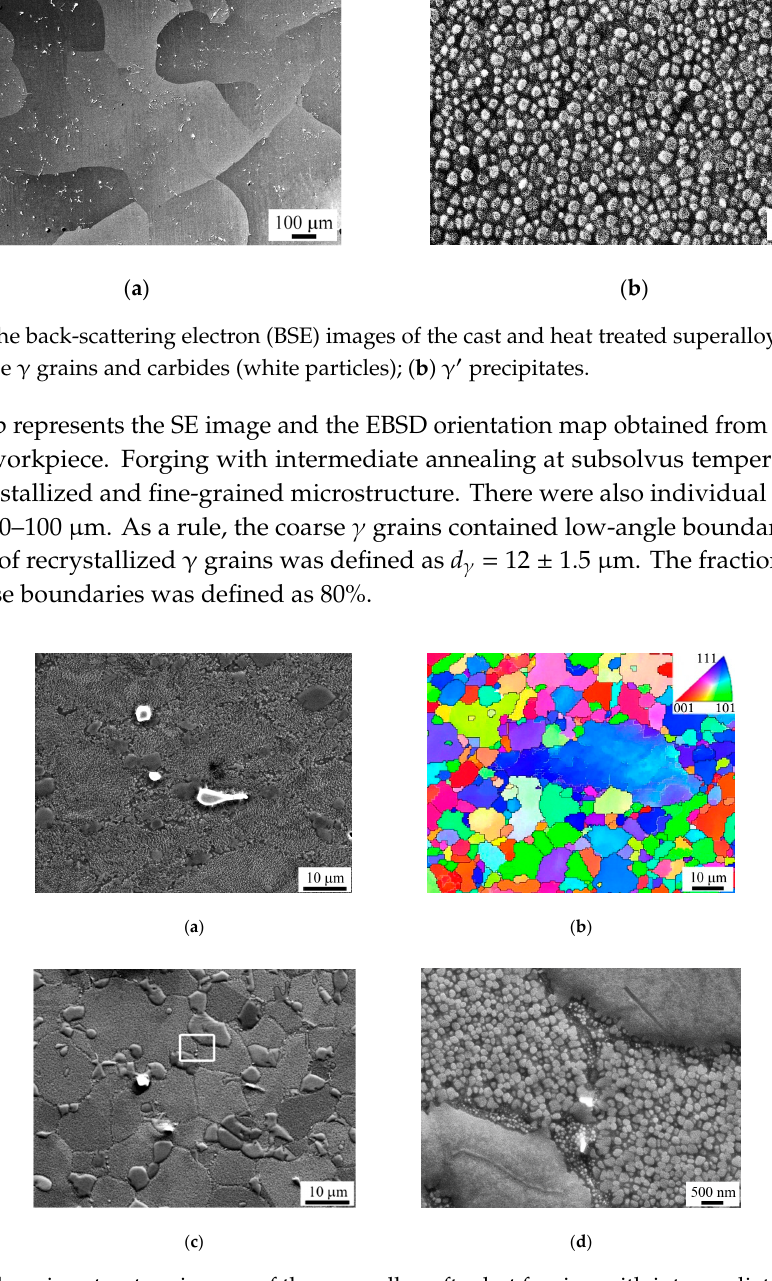
Figure 2. The microstructure images of the superalloy after hot forging with intermediate annealing ( a , b ) and ageing (condition 2) ( c , d ): ( a ) secondary electron (SE) image showing the primary, secondary γ ′ phase and white carbides, ( b ) normal-direction electron backscatter diffraction (EBSD) (inverse-pole-figure) map, the forging axis is vertical, high- and low-angle grain/interphase boundaries are indicated by black and white lines, respectively; ( c , d ) SE images illustrating the primary, secondary, tertiary γ ′ phase and white carbides including fine carbide particles ( d ) precipitated during ageing. The image ( d ) was obtained from the area marked by the rectangle in ( c ).